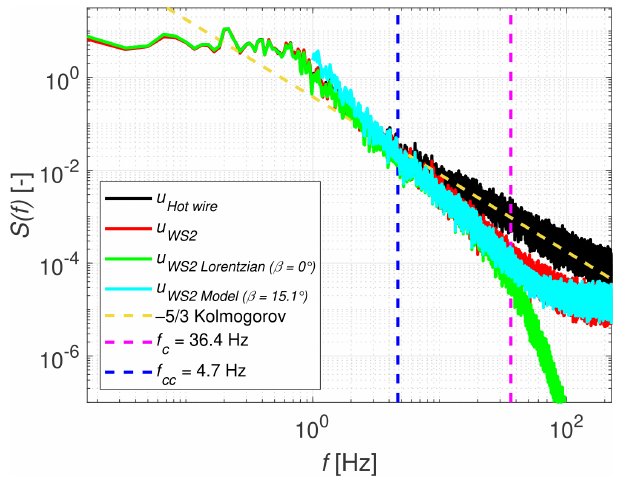
Figure 23. Spectrum of WindScanner 2 (measurements and model) for a turbulence intensity of 22% (Case 1b).